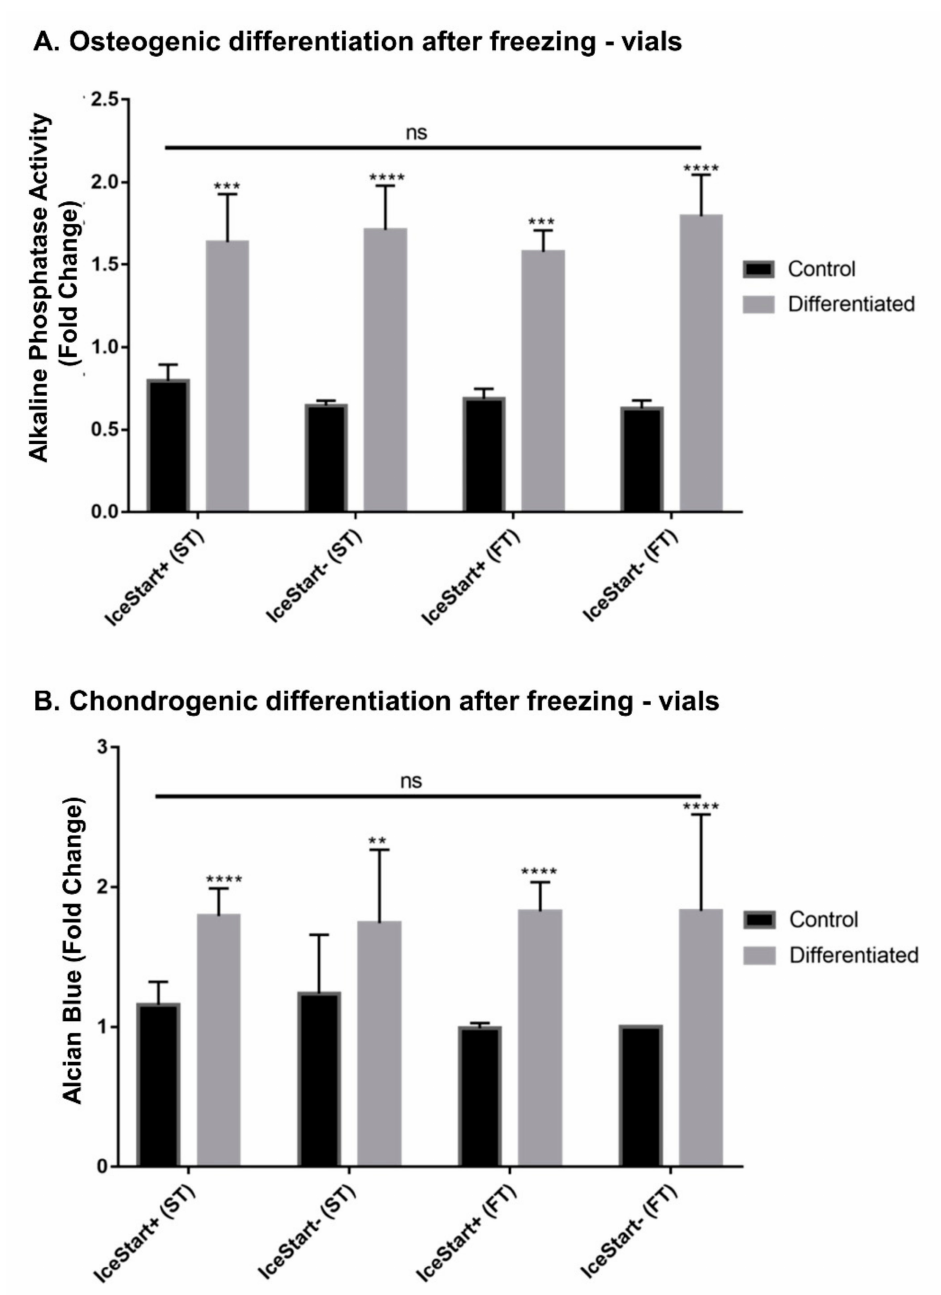
Figure 7. Quantitative analysis of osteogenic and chondrogenic di ff erentiations. All di ff erentiation conditions significantly greater than no di ff erentiation controls with no significance between